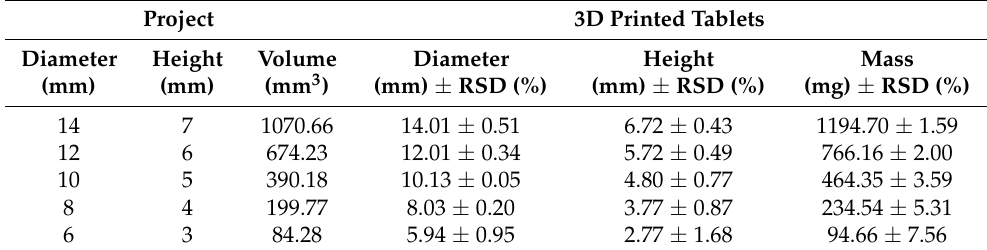
Figure 12. Top and side views of 3D printed MEB-loaded tablets with different volumes. Table 8. Parameters characterizing the designed and printed tablets ( n =